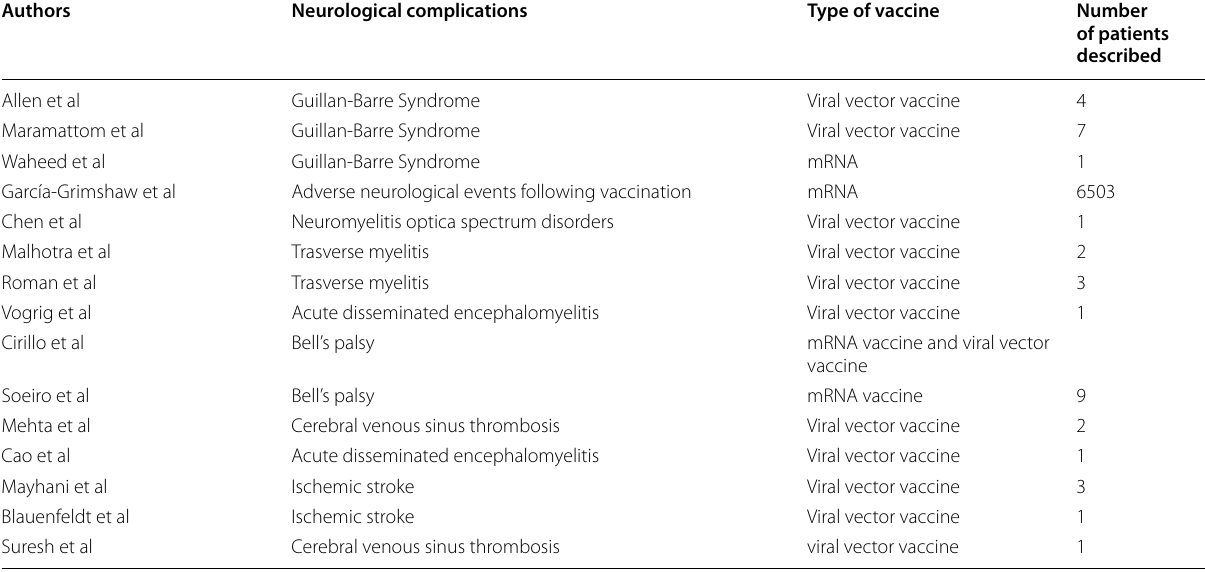
Table 2 Previous case-report about vaccine-related neurological